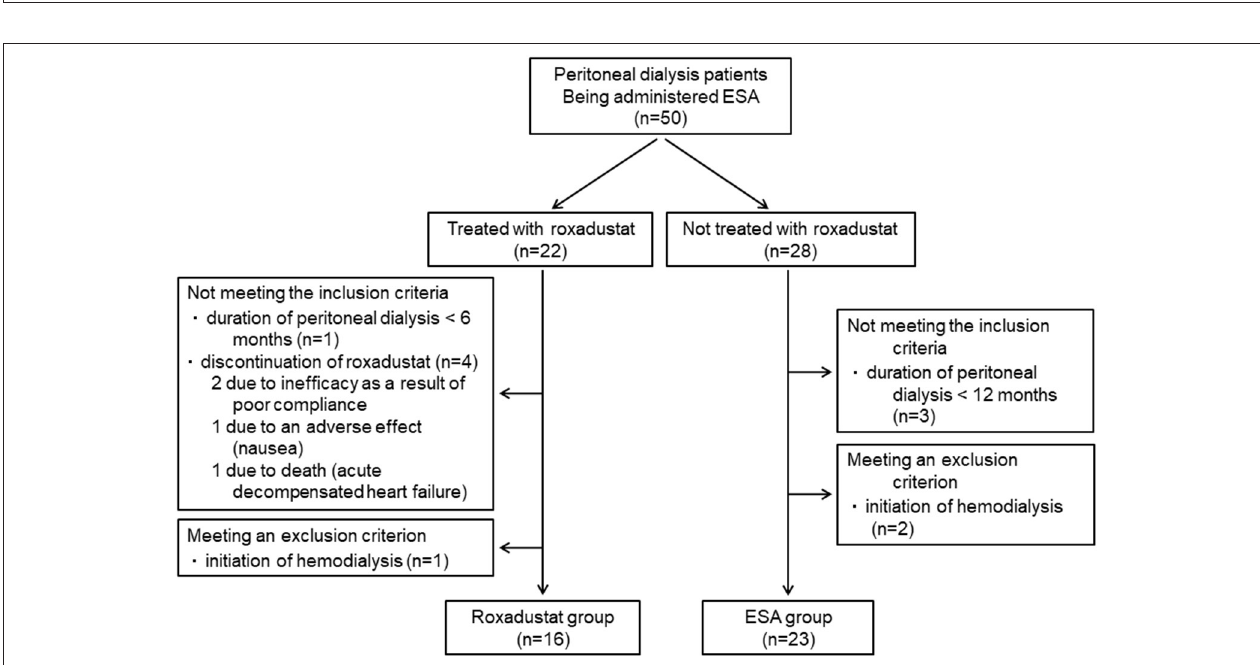
FIGURE 2 | Patient flow diagram. ESA, erythropoiesis-stimulating agent.